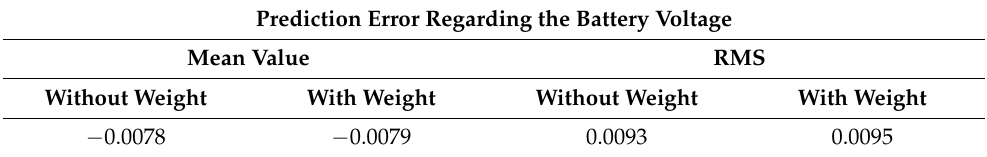
Table 5. Mean and RMS values of the prediction error (battery